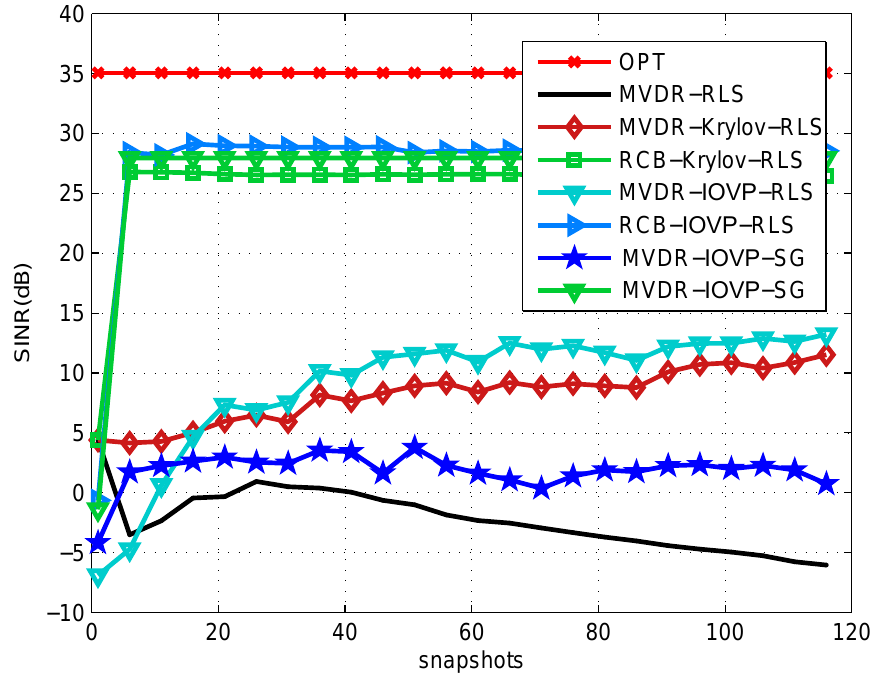
Figure 4. SINR performance against the number of snapshots with steering vector mismatch due to 2°DoA mismatch. The spherical uncertainty set is assumed for robust beamformers [ i ] with (cid:15) = 800 , non-orthogonal S C 320 × 2 rank reduction D ∈